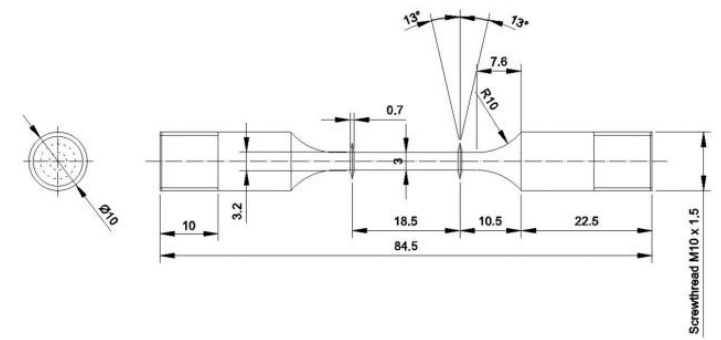
Figure 1. Dimensions of the specimen for creep tests in mm.